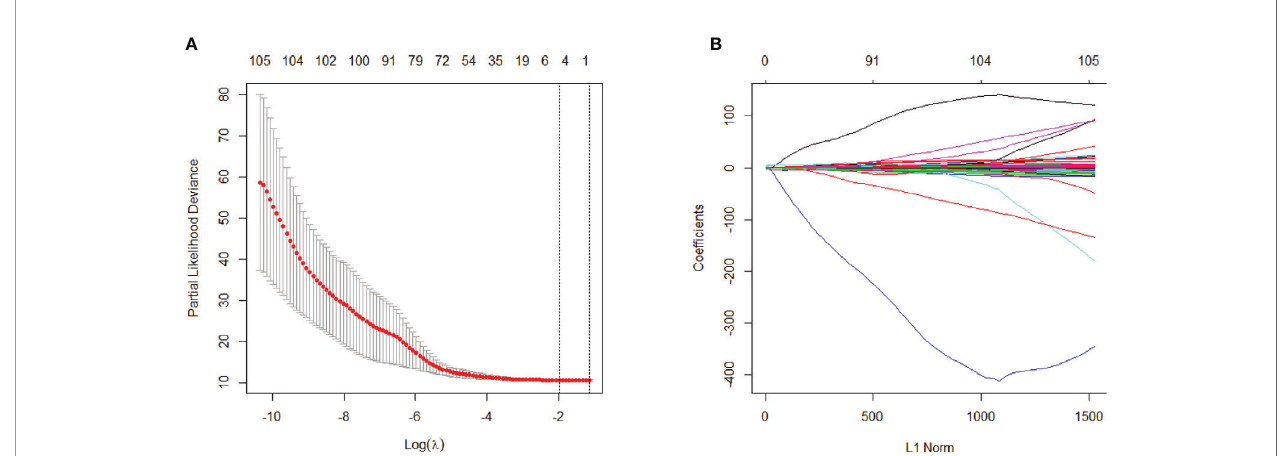
FIGURE 2 | Selection of survival associated radiomics features using the elastic net method, (A) Tuning parameter ( l ) in the elastic net used 10-fold cross-validation via maximum area under curve and criterion of minimum standard deviation were followed; (B) The coef fi cient pro fi les of 105 radiomics features against the L1 norm (inverse proportional to log l ).